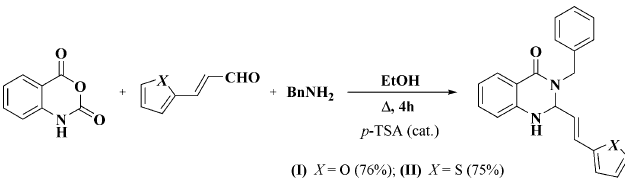
Figure 5 The crystal structure of (II), demonstrating the hydrogen-bonded helicoidal chains propagating in the [010] direction. Dashed lines indicate the intermolecular N—H (cid:3)(cid:3)(cid:3) O hydrogen bonds.